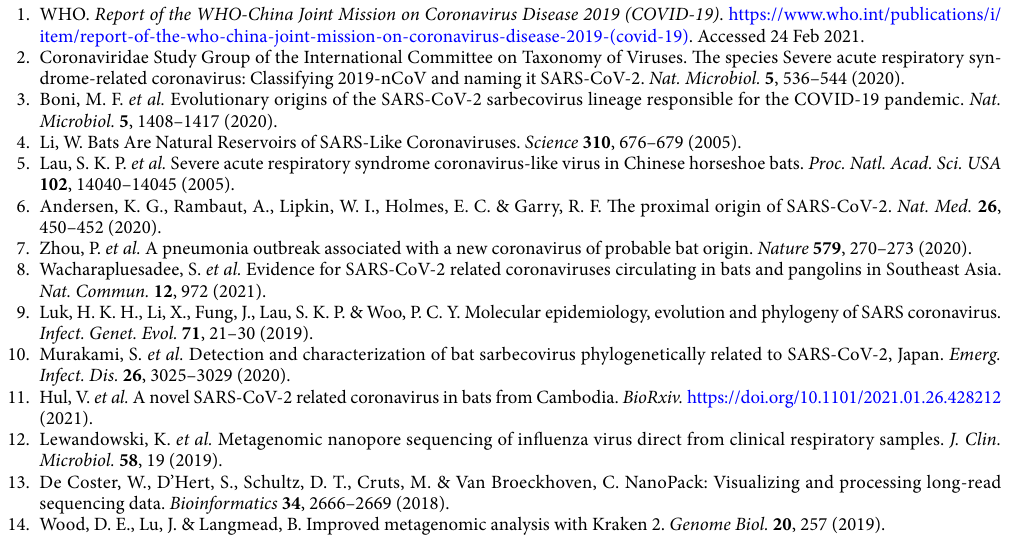
Figure 4. Amino acid sequence and STAMP structural alignments of the RBD of SARS-CoV and SARS- CoV-2 compared to a predicted 3D structure of the RBD of RhGB01 highlighting structural differences in regions housing hACE2 contact residues for SARS-CoV and SARS-CoV-2. Contact residues are described in the literature (black), with residues in red the most identified residues. Regions coloured in purple have high structural similarity (> 0.7) and residues with a low structural similarity coloured in red/white (< 0.3). BM48- 31 is included as comparison to a second Sarbecovirus from a bat source. ( A ) STAMP alignment of SARS- CoV-2 RBD (PDB ID 6M0J) in the conformation of being complexed with hACE2 aligned with the RhGB01 RBD. The areas where structural similarity is low are seen to contain contact residues defined in the literature. ( B ) Sequence alignment of RhGB01 and SARS-CoV-2. The sequence used is identical to ( C ). ( C ) Sequence alignment of the RBM with 28 residues up and downstream, to facilitate the inclusion of K417. The coordinates provided refer the SARS-CoV-2 (NC_45512.2) residue position within the spike protein alignment. ( D ) STAMP alignment of SARS-CoV RBD (PBD ID 2DD8) aligned with the predicted RhGB01 RBD. The region highlighted in green are residues upstream and downstream of the structural alignment which do not align. ( E ) Sequence alignment of RhGB01 and SARS-CoV. ( F ) Sequence alignment of RBM with SARS-CoV contact residues highlighted, and the coordinates provided refer to the residue position for SARS-CoV (NC_004718.3) within the spike protein alignment. 28 residues are included up and downstream of the RBM to include